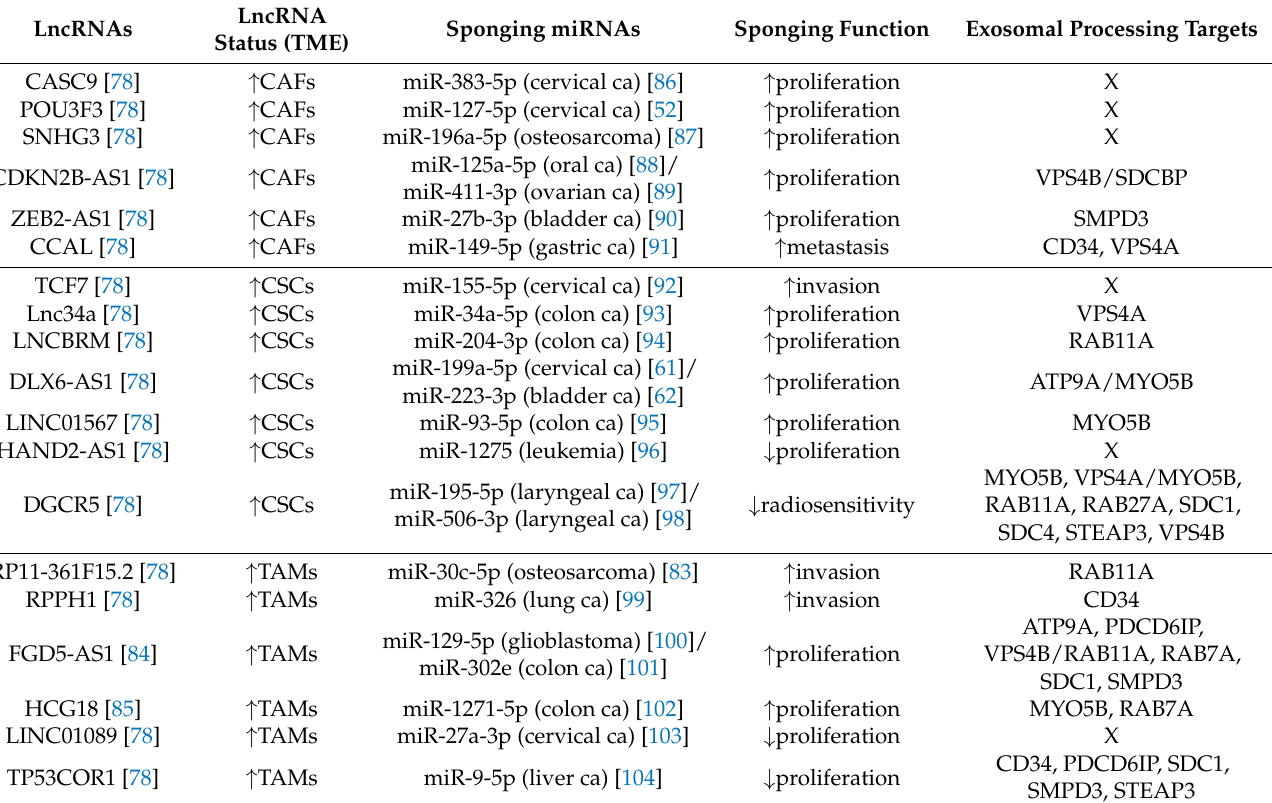
Table 2. Predicted sponging miRNAs of TME-associated lncRNAs and sponging miRNAs’ exosomal processing